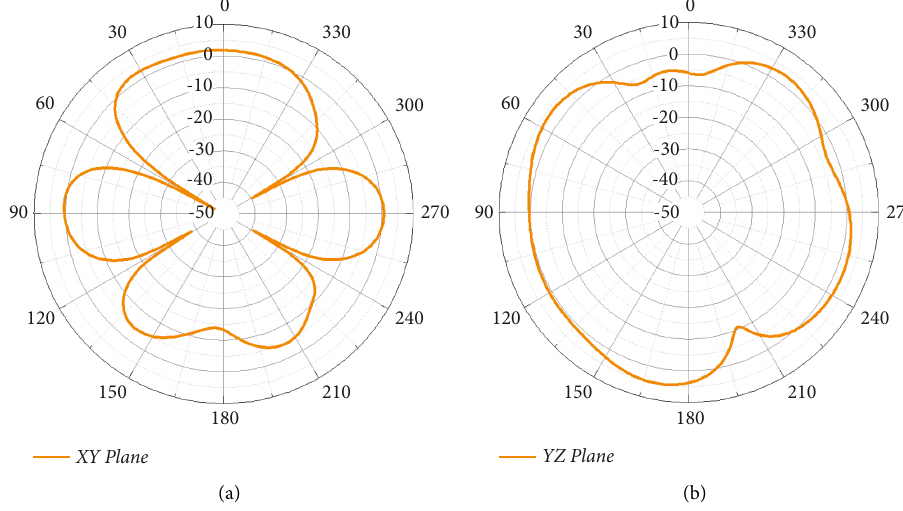
Figure 15: 2D Radiation Patterns (1 × 2 Array) on (a) XY plane, and (b) YZ plane.